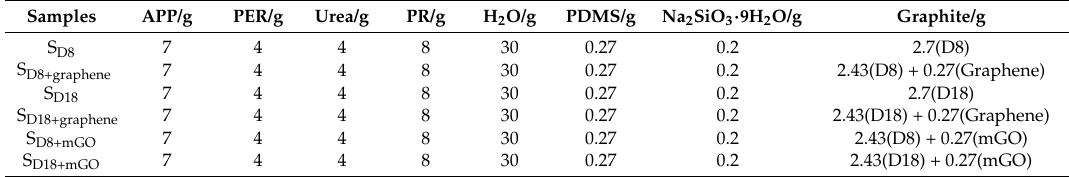
Table 1. Compositions of organic-inorganic hybrid